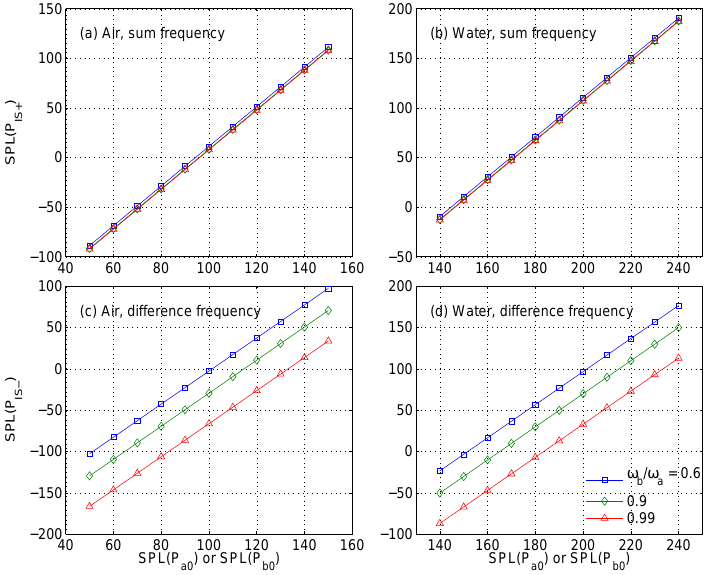
Figure 14. Sound Pressure Level (SPL) of P IS ± in the forward direction as a function of incident SPL at large range in air and water for ω b / ω a = 0.6, 0.9 and 0.99 assuming P a 0 = P b 0 and | S a | = | S b | = 1. The SPL in air, ( a , c ), is referenced to 20 µ Pa and the SPL in water, ( b , d ), is referenced to 1 µ Pa. In ( a , c ) for air, high frequency incident SPL between 120 dB and 140 dB re 20 µ Pa gives sum frequency SPL between 48 dB to 88 dB re 20 µ Pa, and difference frequency SPL between 38 dB and 77 dB re 20 µ Pa respectively, for ω b / ω a = 0.6. Similarly, in ( b , d ) for water, high frequency incident SPL between 170 dB and 190 dB re 1 µ Pa gives sum frequency SPL between 48 dB to 90 dB, and difference frequency SPL between 37 dB and 77 dB respectively, for ω b / ω a = 0.6. With moderate to high incident SPLs, these sum and difference frequency second order waves can be measurable at long